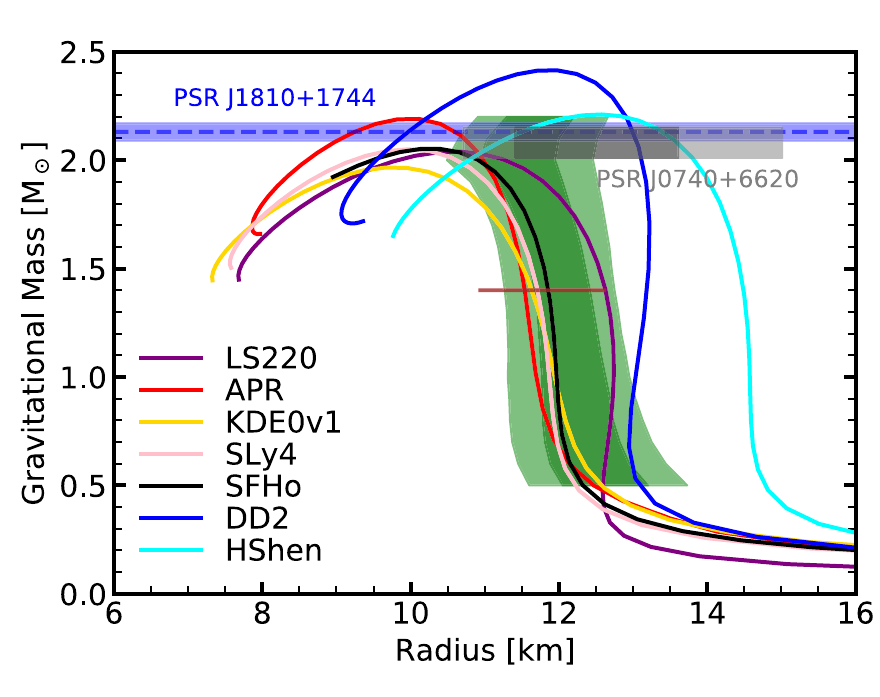
Figure 1. Gravitational mass vs radius, from the various equations of state adopted in the present work. The green shaded region shows the NS mass-radius constraints from model A of [39]. The grey band represents the mass and radius of the millisecond pulsar PSR J0740+6620 . The mass has been measured by [40] and [41], with a value of 2 . 08 ± 0 . 07 M (cid:4) . The radius has been independently estimated by [42] and [43] using NICER data. Here we show the latter, where the lighter grey region represents a km, while the darker region shows the 1 σ 95% confidence level, corresponding to a radius of 12 . 39 + 2 . 63 − 1 . 68 km. The blue dotted line is the mass of PSR confidence level, corresponding to a radius of 12 . 39 + 1 . 30 − 0 . 98 J1810+1744 measured by [44], and the shaded blue region represents the 1 σ confidence level. The brown horizontal band shows the constraint on the radius of a 1.4 M (cid:4) neutron star from